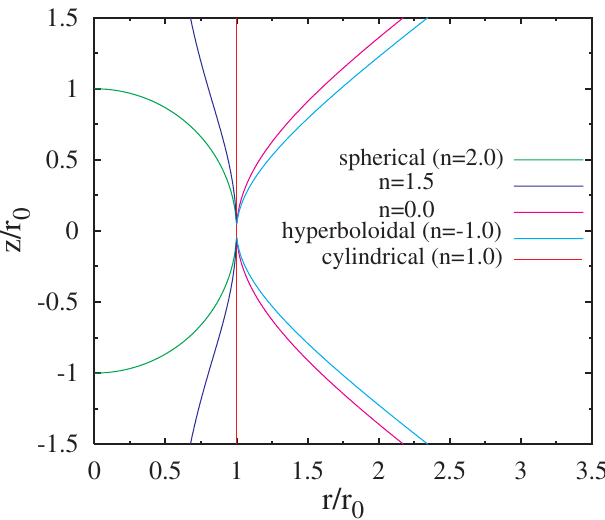
FIG. 7. (Color) Cross sectional shapes of various electrodes in the r - z plane of the cylindrical coordinate system. The shapes of the electrodes are equal potential curve. The variables have been scaled by the curvature radius of the electrode r zontal plane. The constant terms of each electrode has been selected so that the electrodes cross at the point (cid:4) r=r (cid:4) 1 ; 0 (cid:5)